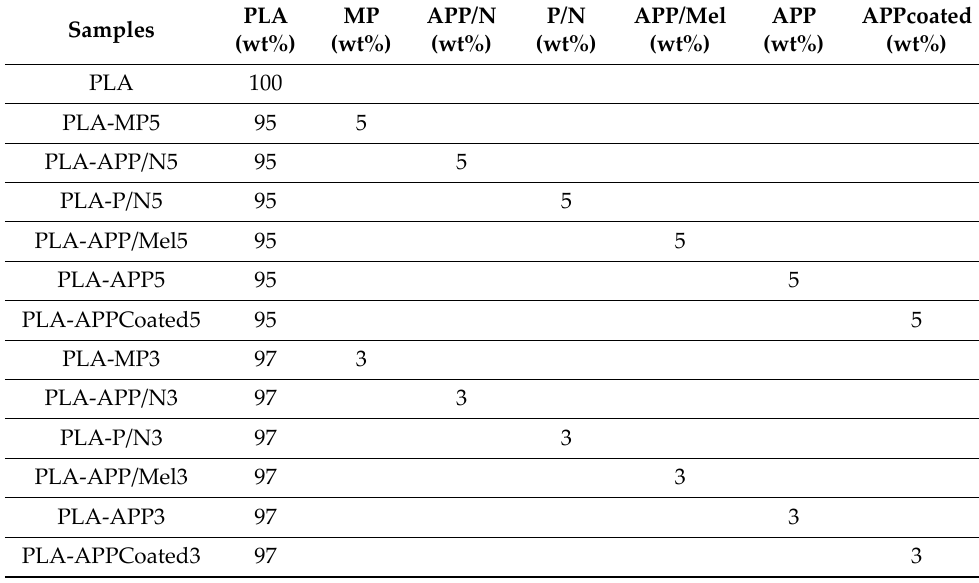
Table 1. PLA with different FRs and their corresponding